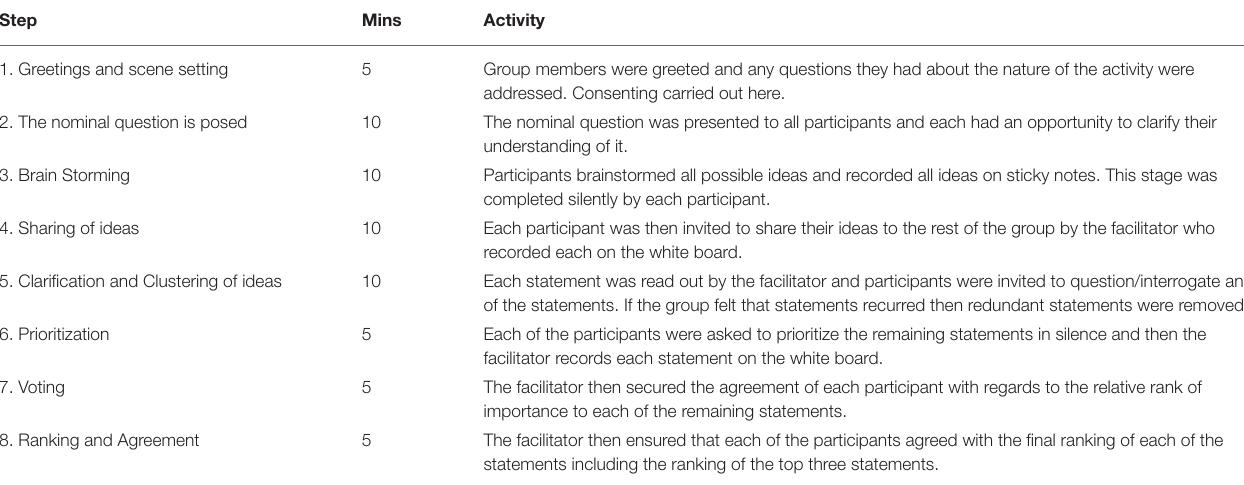
TABLE 1 | Summary of each of the stages of the NGT protocol that were carried out in each of the three focus